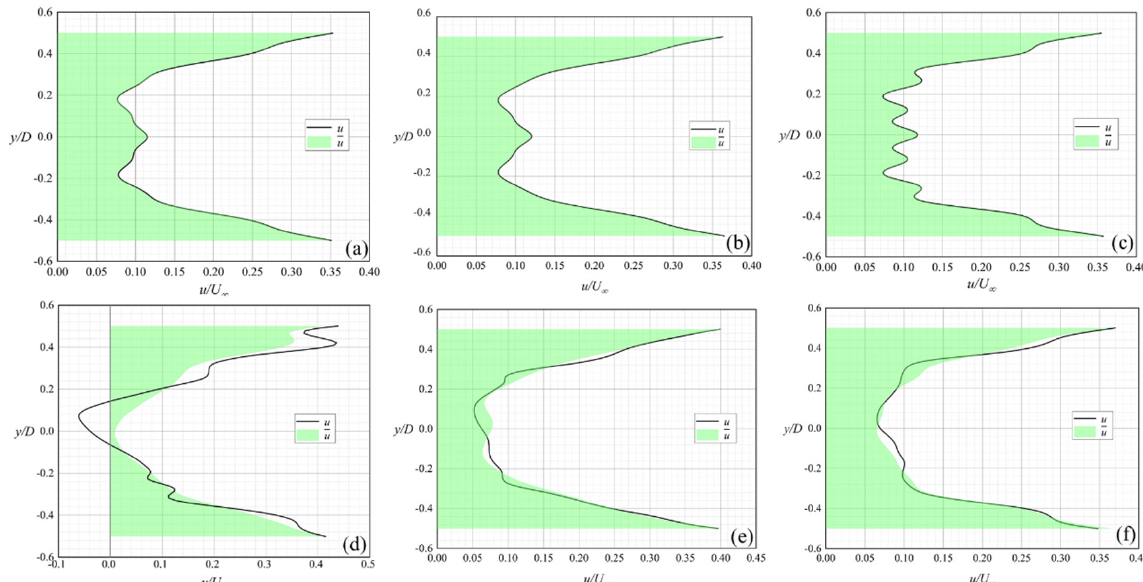
Figure 11. The black curve indicates the transient longitudinal flow velocity u distribution, and the green area indicates the cumulative plot of the mean longitudinal flow velocity u to the line u / U ∞ = 0. ( a ) case Ⅰ , ( b ) case Ⅱ , ( c ) case Ⅲ , ( d ) case Ⅳ , ( e ) case Ⅴ , and ( f ) case Ⅵ .